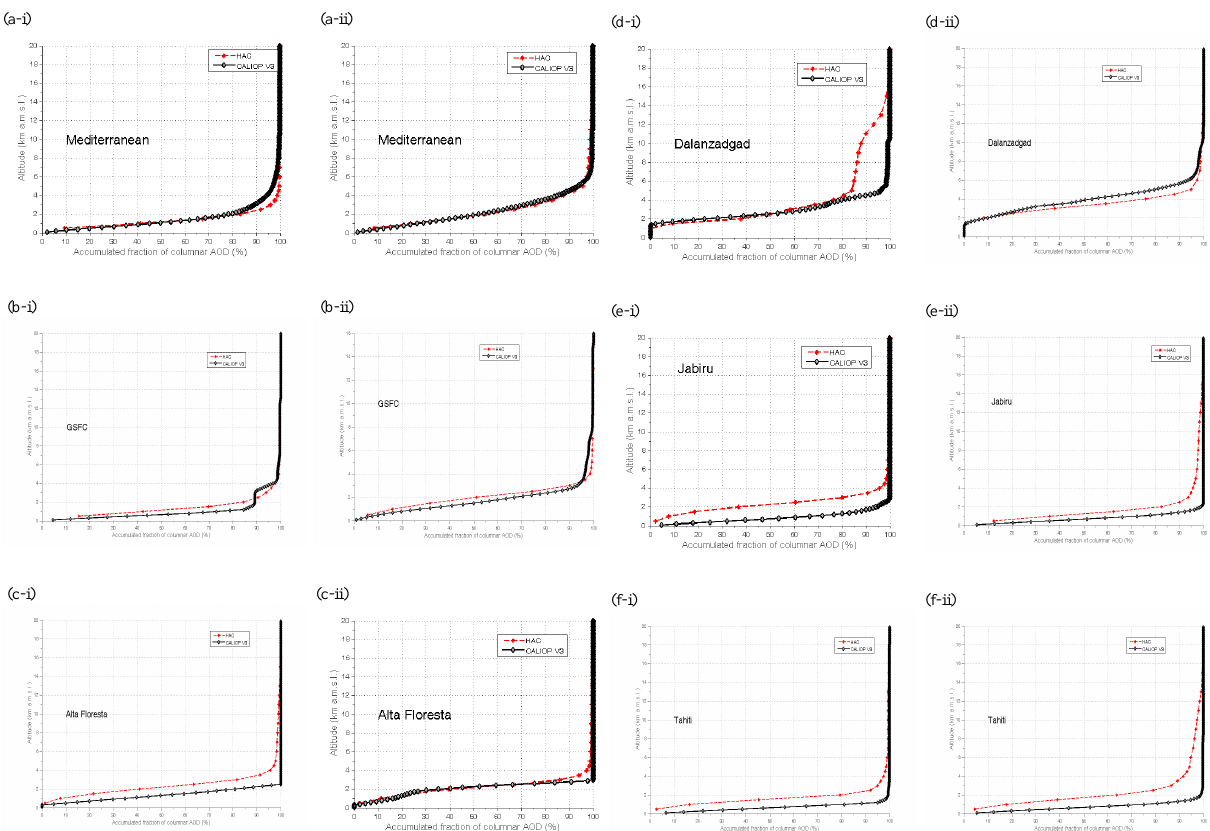
Figure 8. Comparison between HAC (black lines and symbols) and CALIOP (red lines and symbols) vertical profiles of accumulated fractions of columnar total AOD. The comparison is made for the Mediterranean basin (a) and for the 5 selected world locations representative for specific aerosol regimes used in section 4: (b) GSFC, (c) Alta Floresta, (d) Dalanzadgad, (e) Jabiru and (f) Tahiti. Results are given separately for January (i) and July (ii), in each case. CALIOP values are for 532nm, while HAC values are for 550nm. Data for specific sites and for Mediterranean region are from July 2006 to January